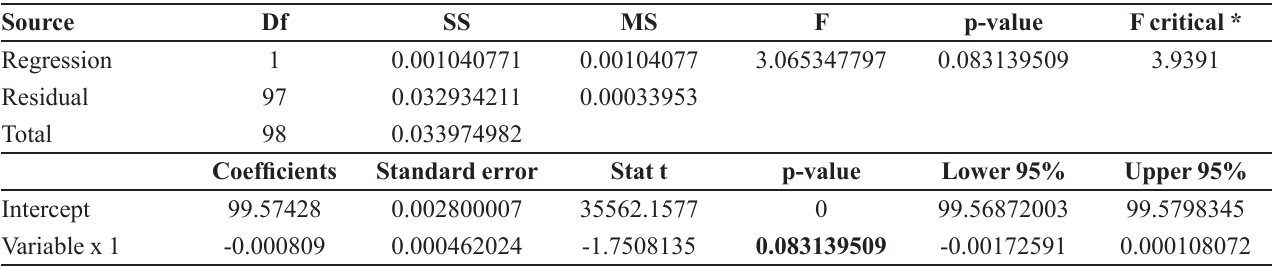
TABLE IV - Regression analysis for short-term stability results Source Df